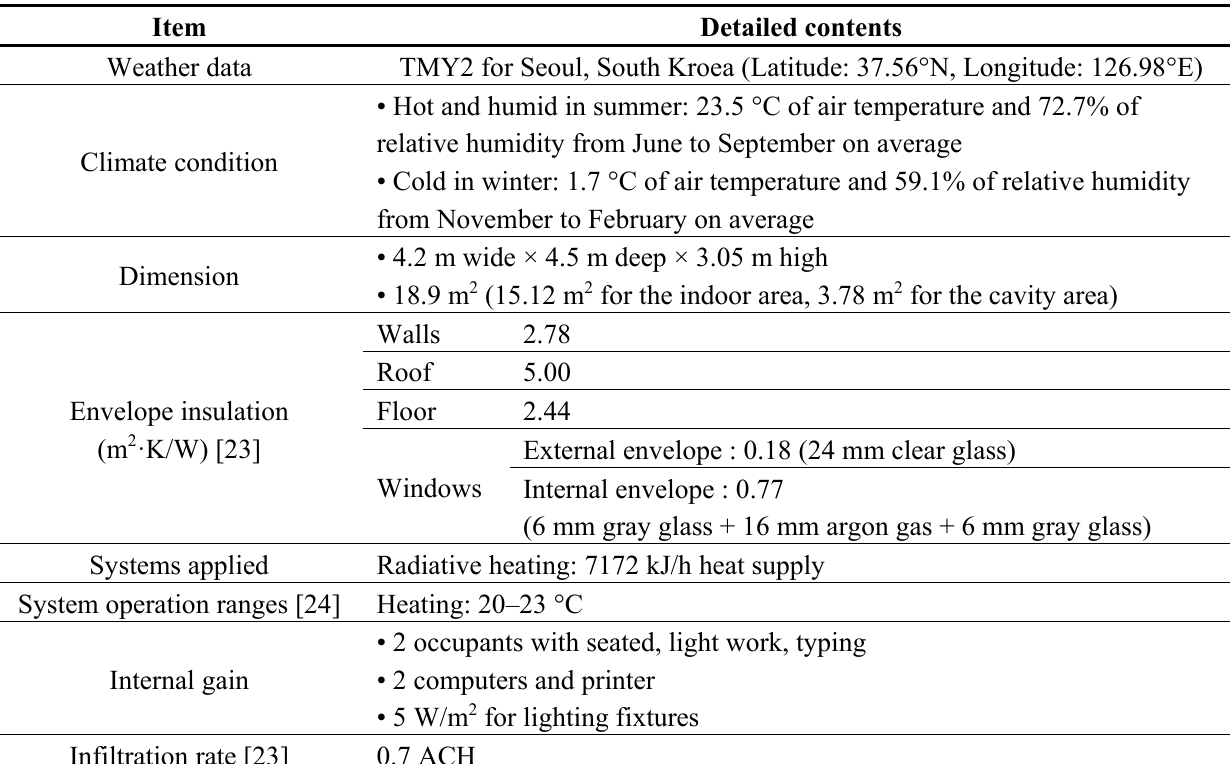
Table 2. Condition of buildings with single and double skin envelope. TMY2: typical meteorological year. ACH: air change rate per